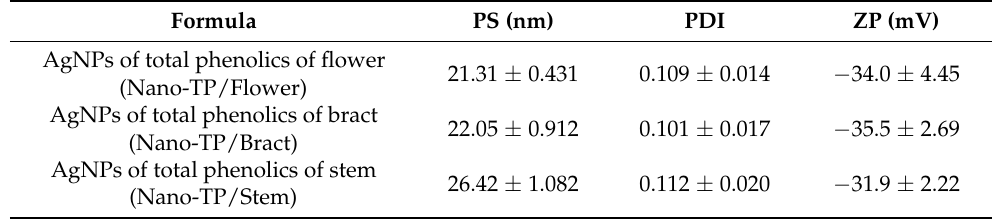
Table 3. Particle size (PS), polydispersity index (PDI), and zeta potential (ZP) of the synthesized AgNPs.